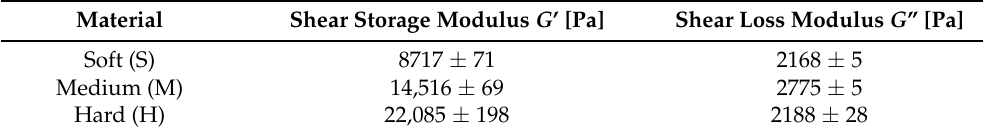
Table 2. Viscoelastic properties of MAE materials used.